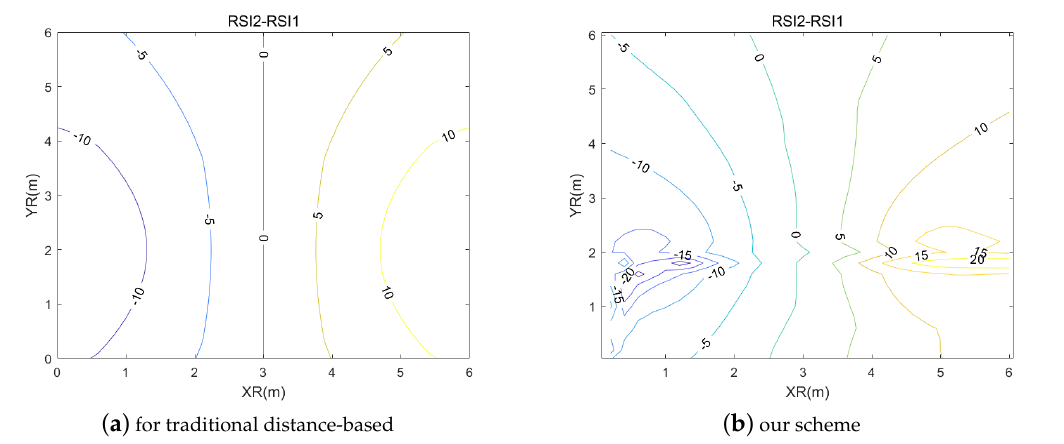
Figure 9. Distribution of the difference between RSI2 and